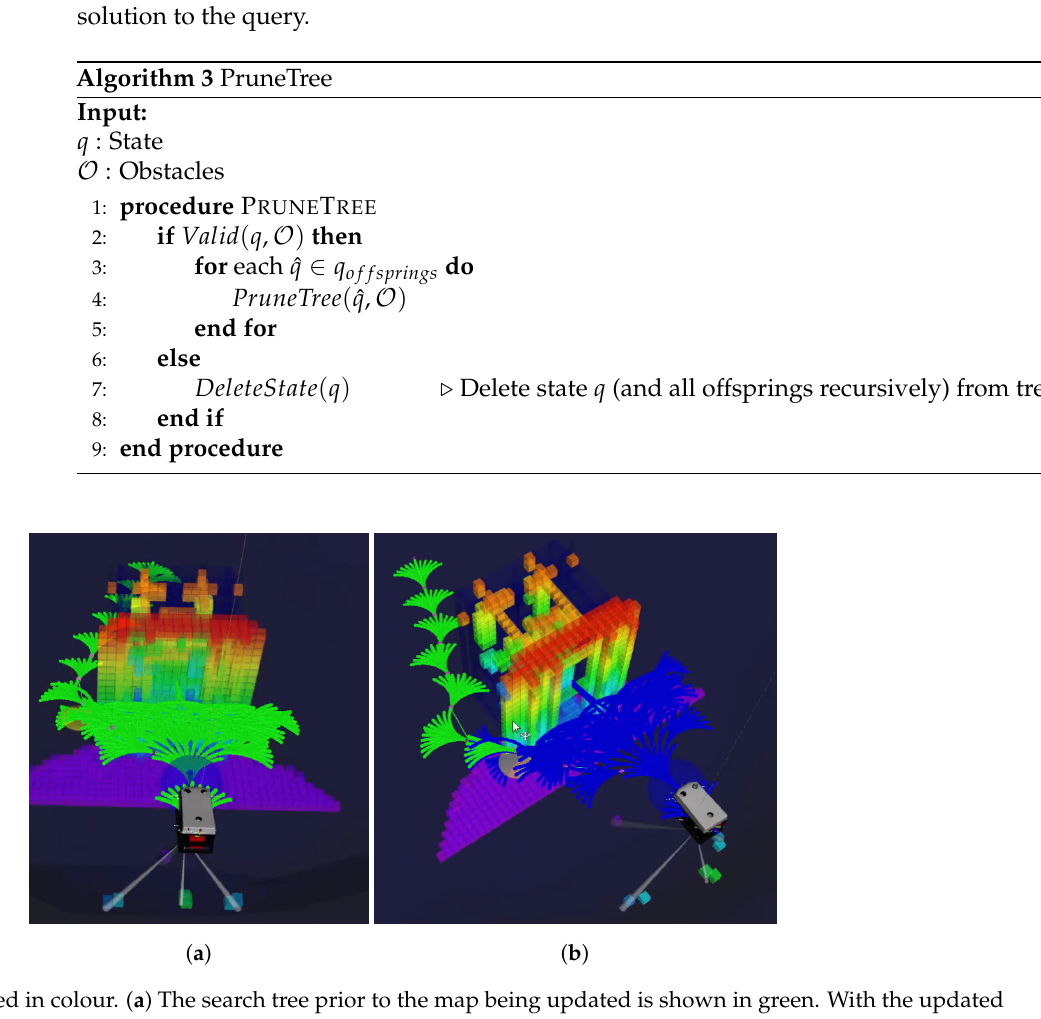
Figure 6. Best viewed in colour. ( a ) The search tree prior to the map being updated is shown in green. With the updated map, the solution is however no longer valid as it intersects with the environment. ( b ) The tree in ( a ) is pruned from branches which are in collision with the environment, the remaining valid tree is shown in blue. The pruned tree is used to initialise the search to find a new solution. The new explored tree required to find a new solution is shown in